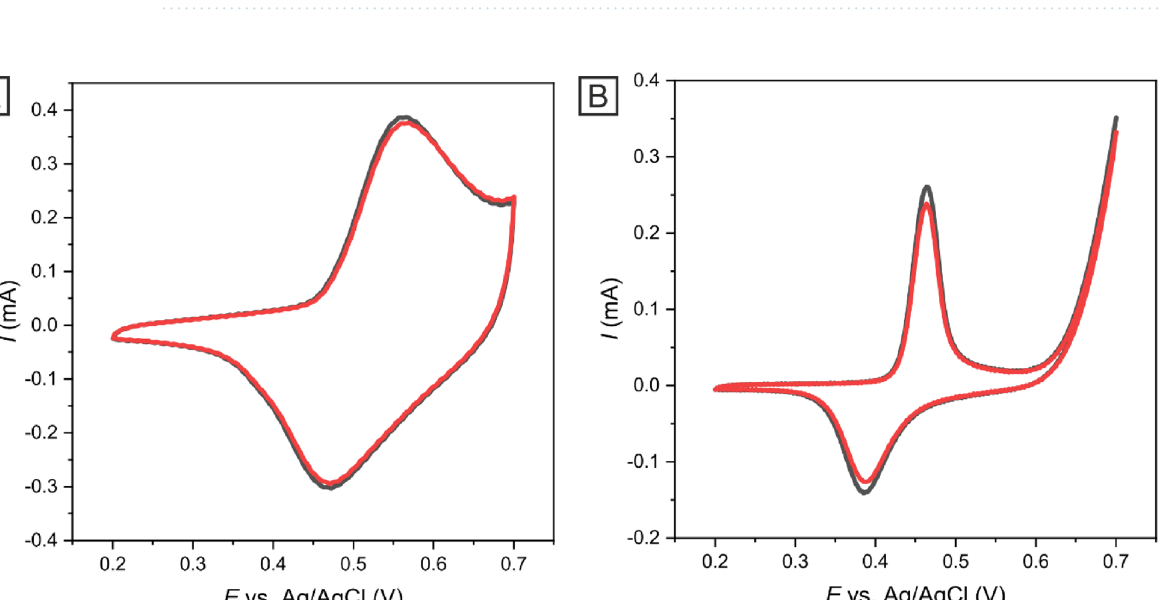
Table 1. Comparison of analytical parameters of nano-modified electrodes used for insulin determination.